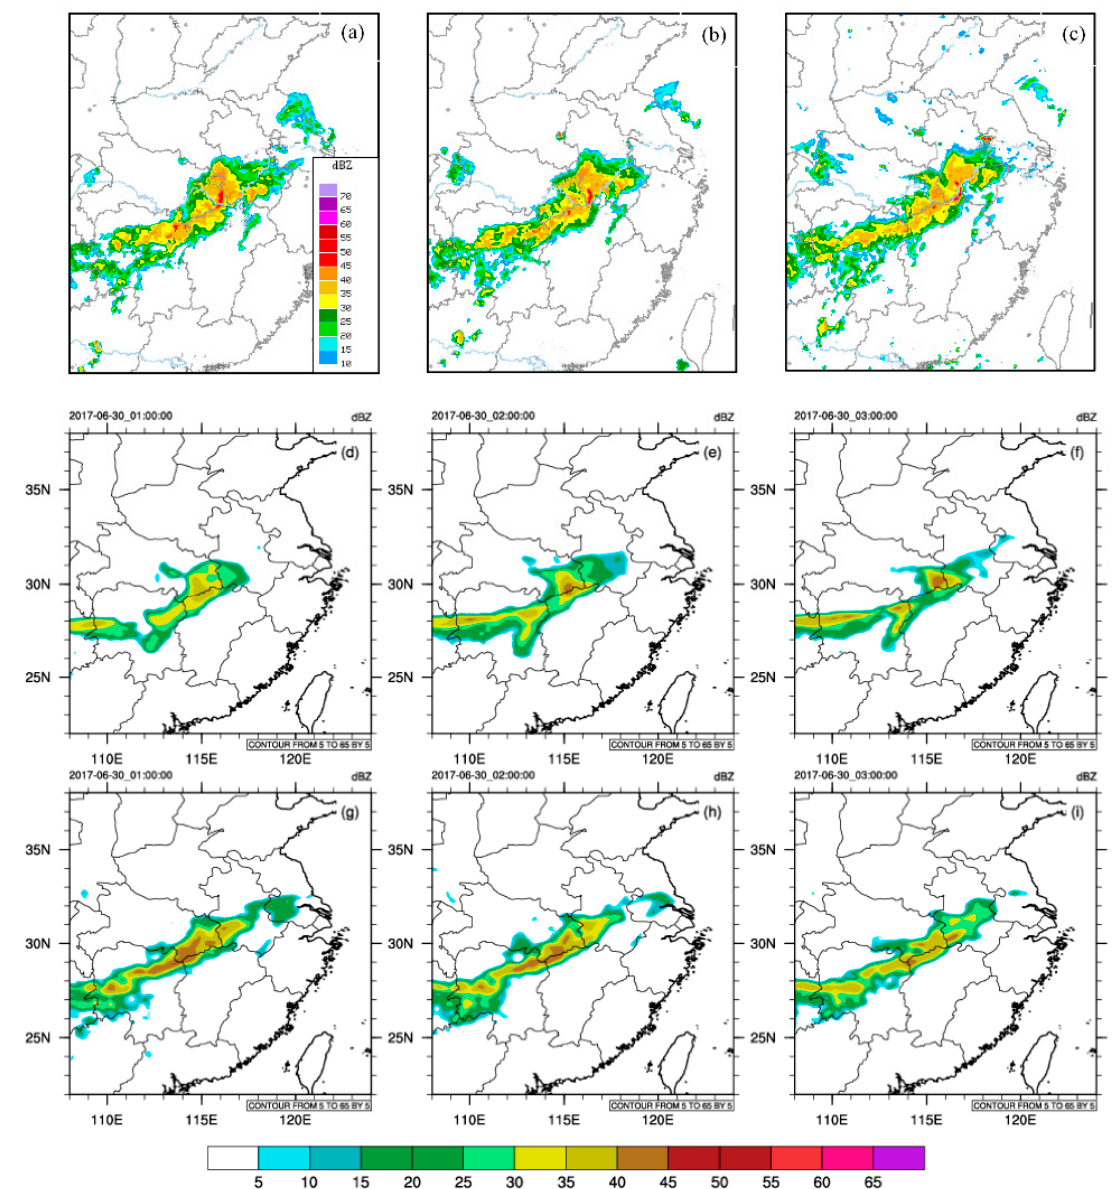
Figure 11. The observed radar reflectivity at ( a ) 0100 UTC, ( b ) 0200 UTC, ( c ) 0300 UTC 30 June 2017, and corresponding simulated reflectivity at the first model level from ( d – f ) CON, and ( g – i ) POD. Figure 12a shows the overlaid of water vapor mixing ratio increments and analysis wind field. Obvious southwesterly flow is found on the south of the precipitation area, advecting warm and moist air from the south. In the main precipitation area (Hunan Province), POD produces positive increments at 700 hPa, improving the water vapor mixing ratio. To better understand the vertical structure of water vapor changes, the cross-section is made along the red line in Figure 12a, which is shown in Figure 12b. Large positive increments appear under 500 hPa, revealing that assimilating satellite data increase water vapor dramatically in the mid-lower level. Similarly, the temperature increments are shown in Figure 12c–d. Negative increments are found mainly at 700 hPa, indicating that assimilation has a cooling e ff ect in the low level of precipitation area. However, the temperature increase is found in the upper level when cross-section is made (Figure 12d). It can be inferred that strong convection develops in the heavy rainfall event, with convective condensation latent heat in the upper level of precipitation